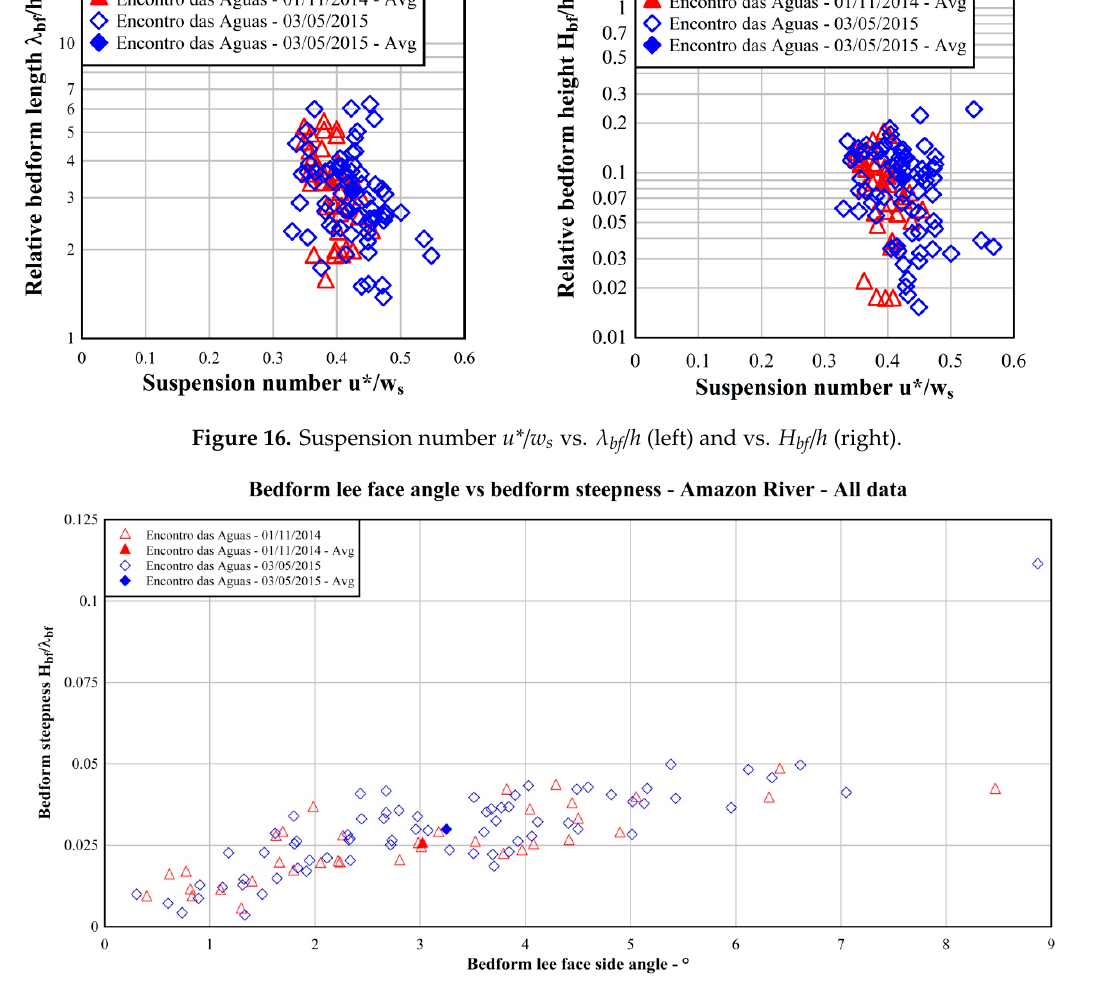
Figure 17. Bedform lee face angle vs. bedform steepness.